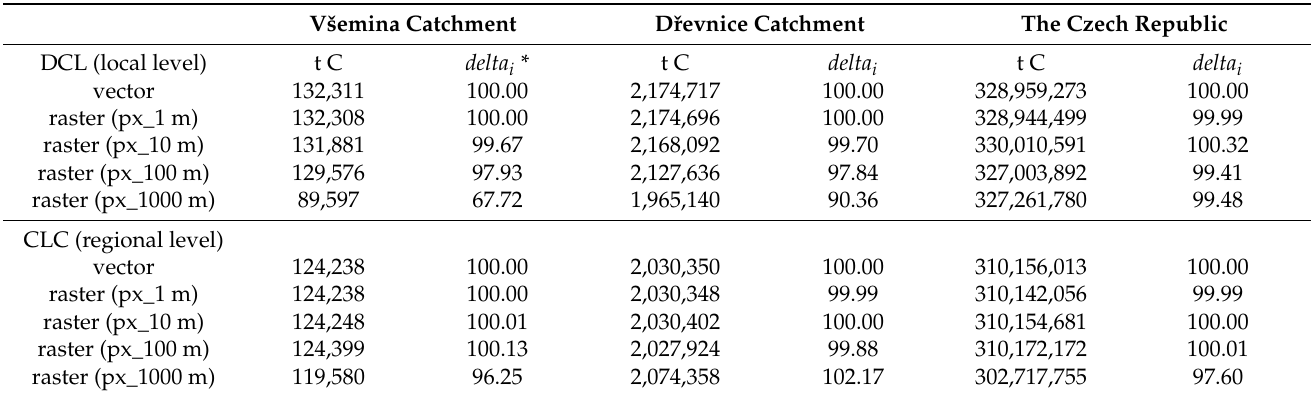
Table 3. Aboveground carbon stock (tons of Carbon; tC) estimated on the basis of vector and raster data in all three studied areas.